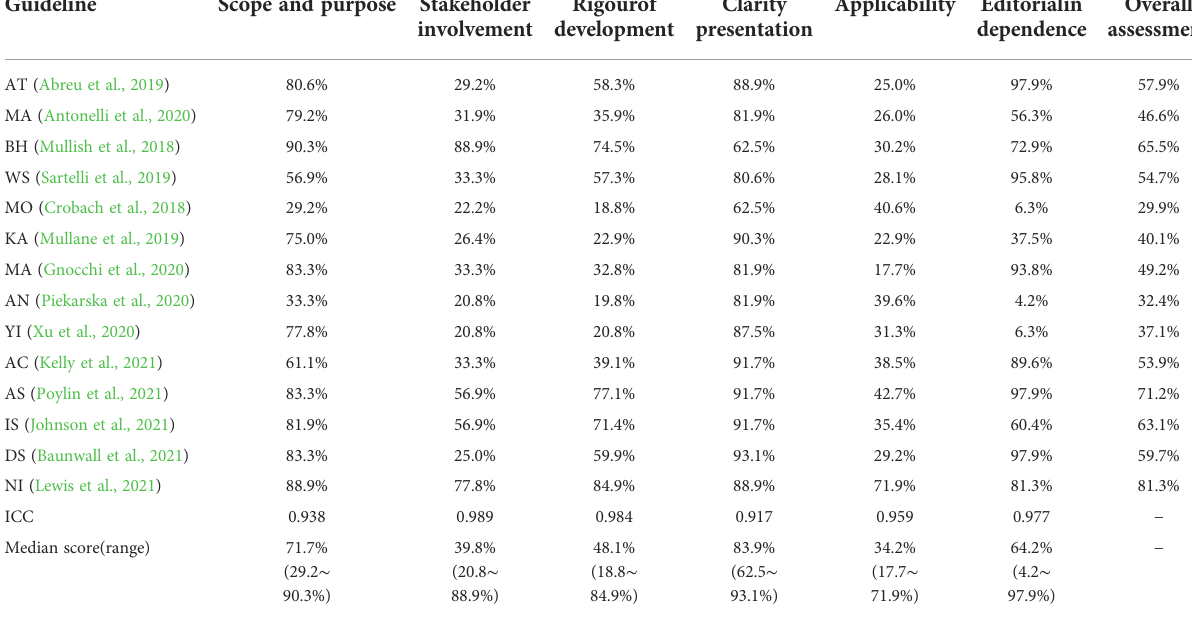
TABLE 2 AGREE Ⅱ domain score and ICC of the included guidelines.